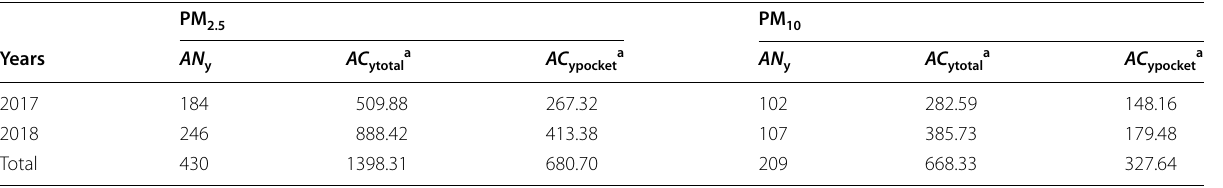
AN y , AC ytotal , and AC ypocket were calculated based on the largest effect estimates in single pollutant models. AN y the number of AF inpatients attributed to exposure to air pollutants on the i th day, AC ytotal the total hospitalization cost by excessive exposure to air pollutants for y years, AC ypocke the out-of-pocket cost by excessive exposure to air pollutants for y